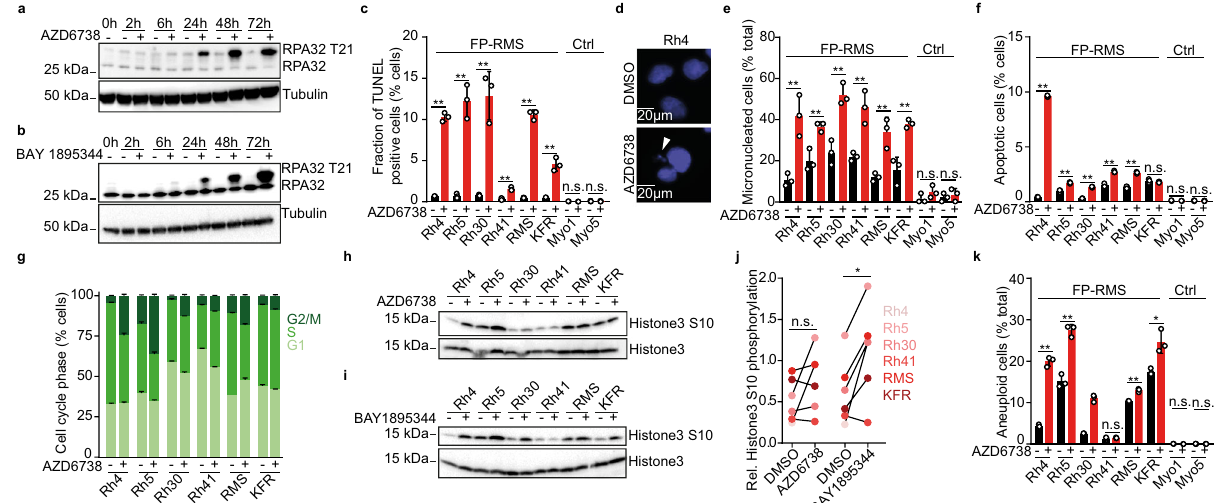
Fig. 2 | ATR inhibition induces replication stress-associated DNA damage, genomic instability, apoptosis and cell cycle disruption. Western immunoblot of RPA32 phosphorylation at T21 in Rh4 cells treated with ATR inhibitor AZD6738 (750nM)( a )andBAY1895344(20nM)( b ). c Quanti fi cationofTUNELsignalincells treated with AZD6738 for 72h. ( n =3; from left to right, P =5.97×10 − 6 ; 6.51×10 − 4 ; 0.002; 0.001; 6.88×10 − 6 ; 9.04×10 − 4 ; 0.734; 0.980). d Representative photo- micrographs of micronucleation in cells. White arrow represents micronuclei. e Fraction of micronucleated cells after treatment with AZD6738 for 72h. ( n =3, with 50 nuclei counted per replicate; P =0.007; 0.007; 0.004; 0.007; 0.007; 0.004; 0.206; 0.768). f Fraction of apoptotic cells after treatment with AZD6738